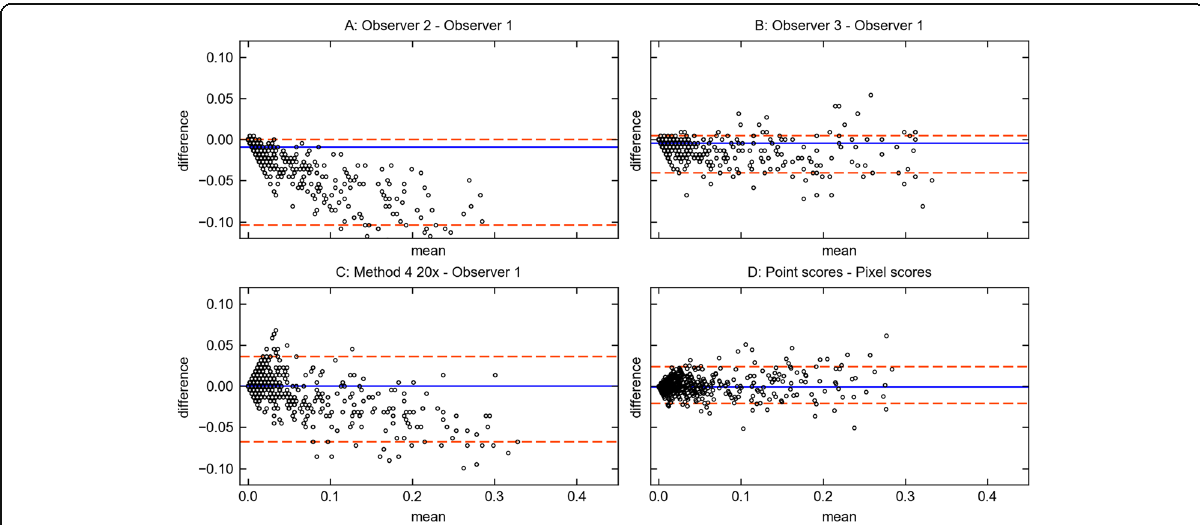
Fig. 7 Bland-Altman plots. a-c : Agreement with Observer 1 of Method 4 and Observer 2 & 3. d : Agreement between point scores and pixel scores of Method 4